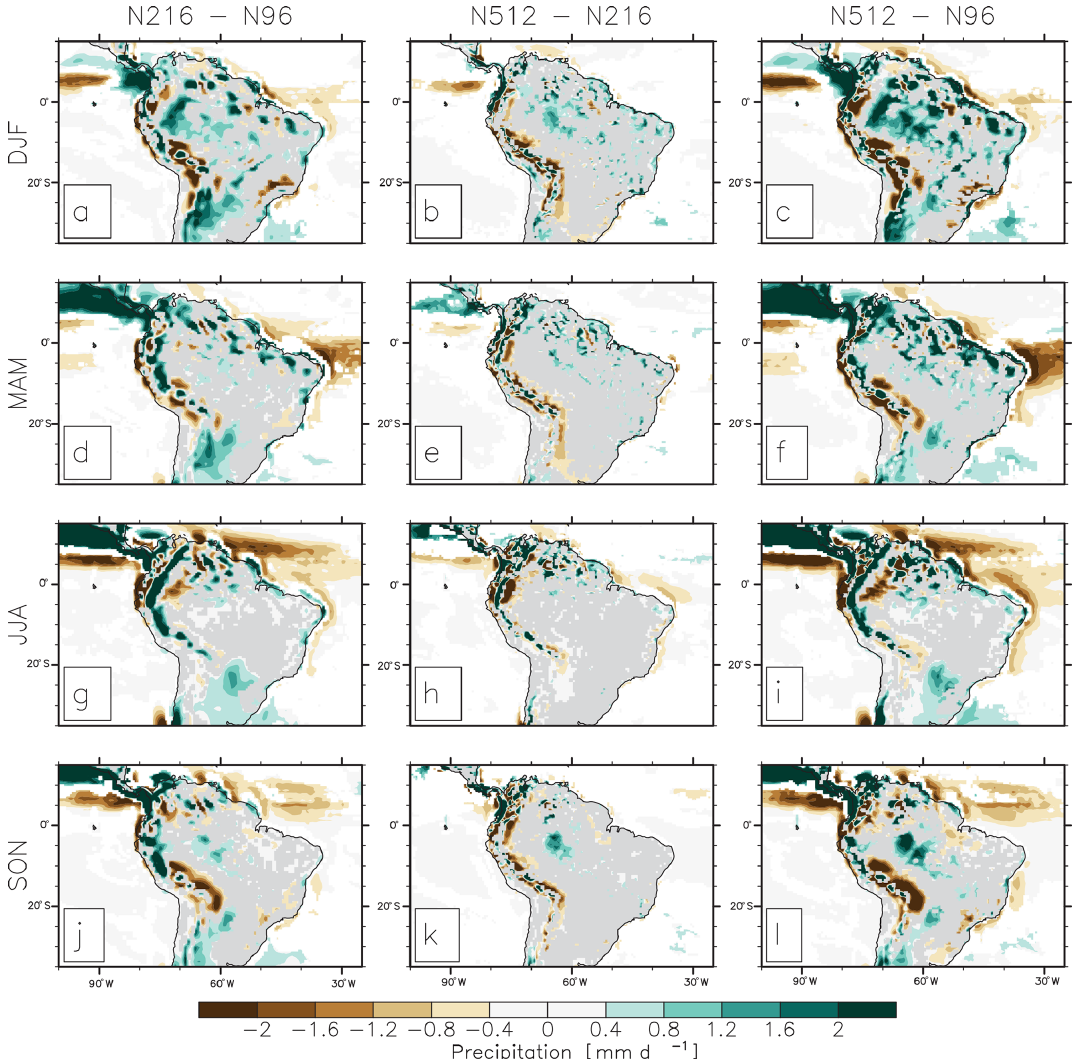
Figure 3. Ensemble-mean N216–N96 difference in (a) DJF, (d) , MAM, (g) JJA, and (j) SON precipitation (mmd − 1 ). (b, e, h, k) As in (a) , (d) , (g) , and (j) but for N512–N216. (c, f, i, l) As in (a) , (d) , (g) , and (j) but for N512–N96. Differences are shown when statistically different to zero according to a Student’s t test and a 95% confidence